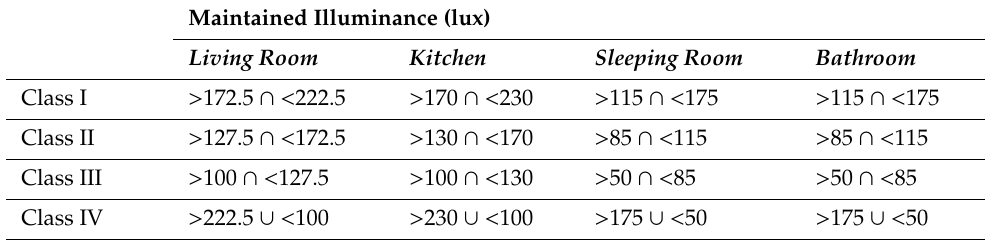
Table 2. Thresholds for each class and intended use of the environment regarding maintained illuminance (E m